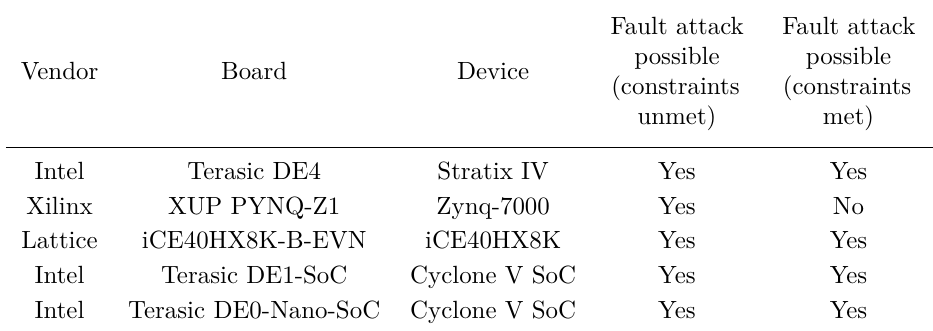
Table 1: First results about general vulnerability of different